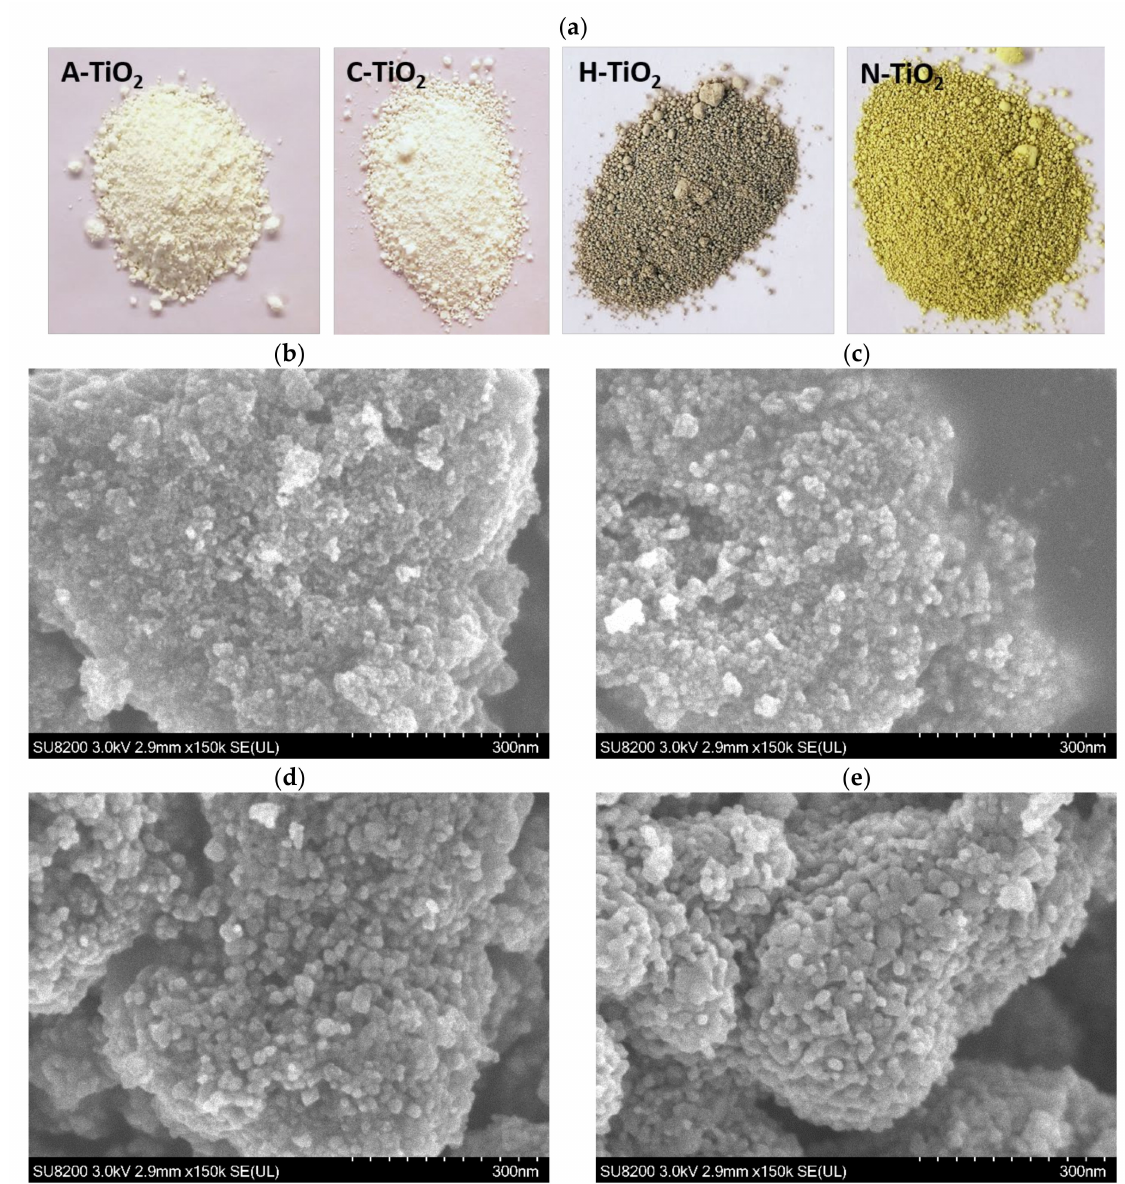
Figure 1. Photographs of the investigated TiO 2 nanocrystals ( a ) and representative SEM images of A-TiO 2 ( b ), C-TiO 2 ( c ), H-TiO 2 ( d ), and N-TiO 2 ( e ), respectively. Scale bar: 300